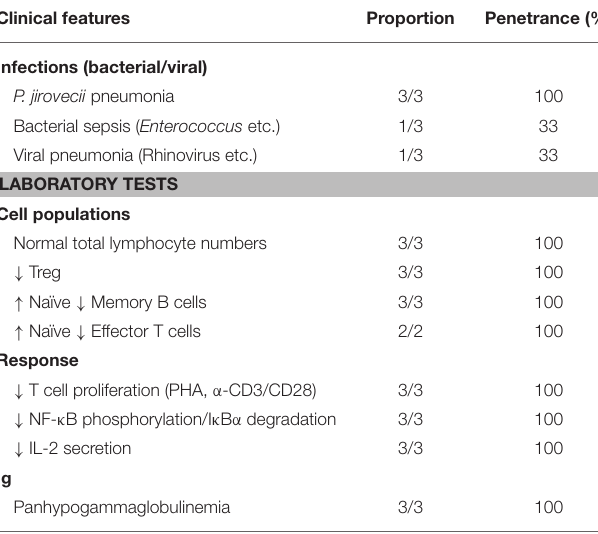
TABLE 3 | “Red flags” suggestive of human CARD11 deficiency (LOF CARD11 mutations). Clinical features